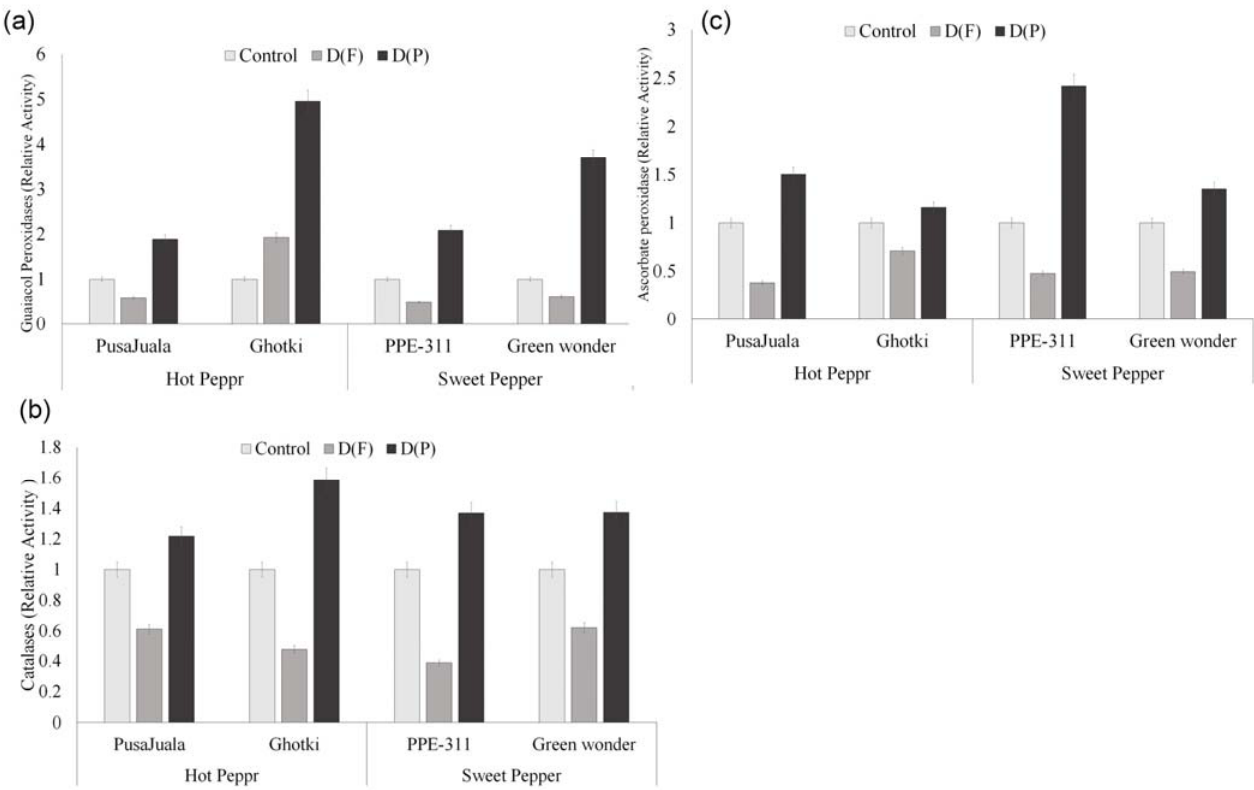
Figure 7. Ascorbate peroxidases (APX), catalase (CAT), and guaiacol peroxidases (GPX) activity of chili fruits. Means of three repetitions for each genotype with the same letters indicate the same means, and different letters indicate significant differences. Vertical bars represent standard error of means (bars = ±se) (LSD p < 0.05). DF = water stress at flowering stage, DP = water stress at the pod formation stage.